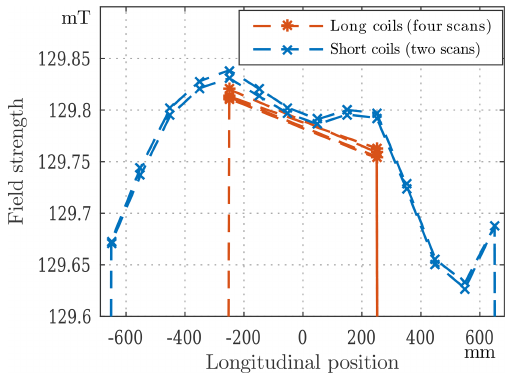
Figure 10. Results of repeated scans with both long and short coils. External positions are removed from the plot to emphasize the de- tails in the straight-field